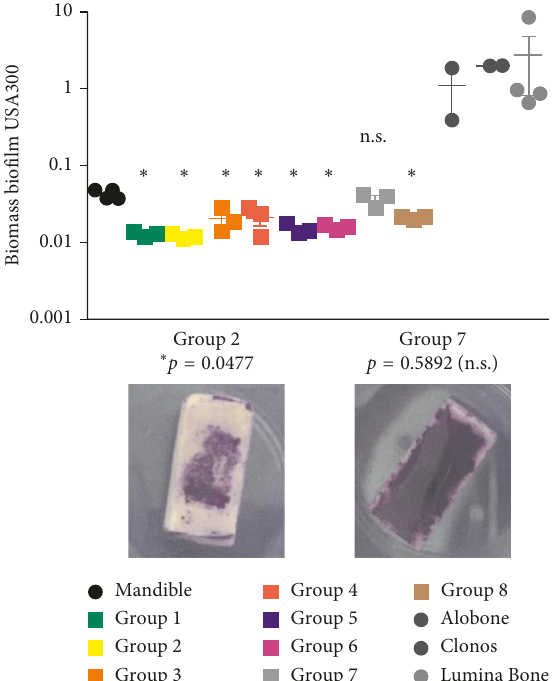
Figure 9: Biomass quantification of Staphylococcus aureus (USA300) biofilm formed on glass-ceramics, mandible, and bone grafts. Representative images of biofilms after staining with crystal violet are shown at the bottom of x -axis (Group 2